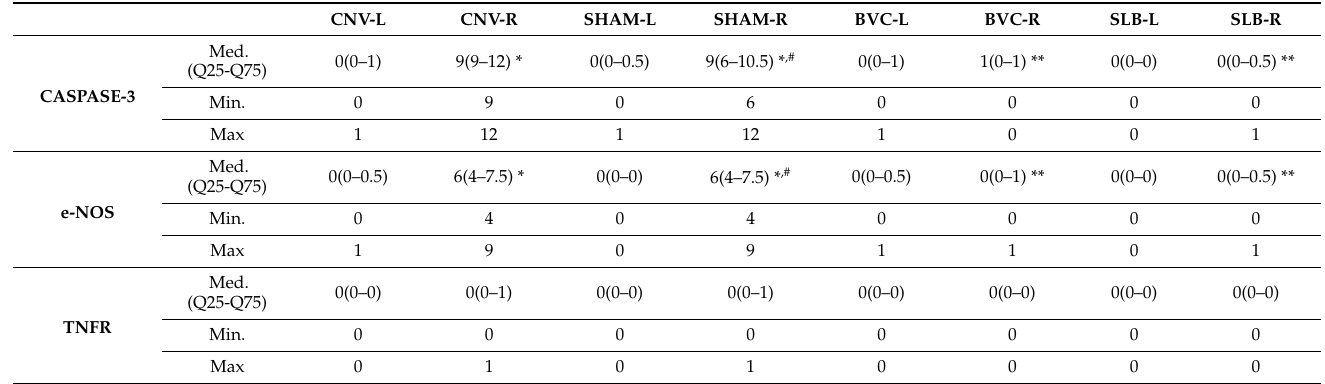
all the groups. According to these results, with caspase-3, e-NOS, and TNFR, no immuno- reactivity was observed in the CNV-L (left eye) (Figure 3A), SHAM-L (Figure 3E), BVC-L (Figure 3I), and SLB-L (Figure 3M) groups. Compared to these groups, caspase-3 and e- NOS activities were significantly increased in the CNV-R (Figure 3B,C) and SHAM-R (Fig- ure 3F,G) groups (all p < 0.001). Compared to the CNV-R and SHAM-R groups, a signifi- cant decrease in caspase-3 and e-NOS immunoreactivity was observed in the BVC-R (Fig- ure 3J,K) and SLB-R (Figure 3N,O) groups (all p < 0.001). TNFR immunoreactivity was negative in all groups (Figure 3D,H,L,P). Table 2. Multiplicative quick score results of caspase-3, e-NOS, and TNFR immunohistochemistry. Data are indicated as median (Q25–Q75), minimum, and maximum values. (Compared to L eyes *: p < 0.001, compared to CNV-R: # : p >0.05, **: p < 0.001).